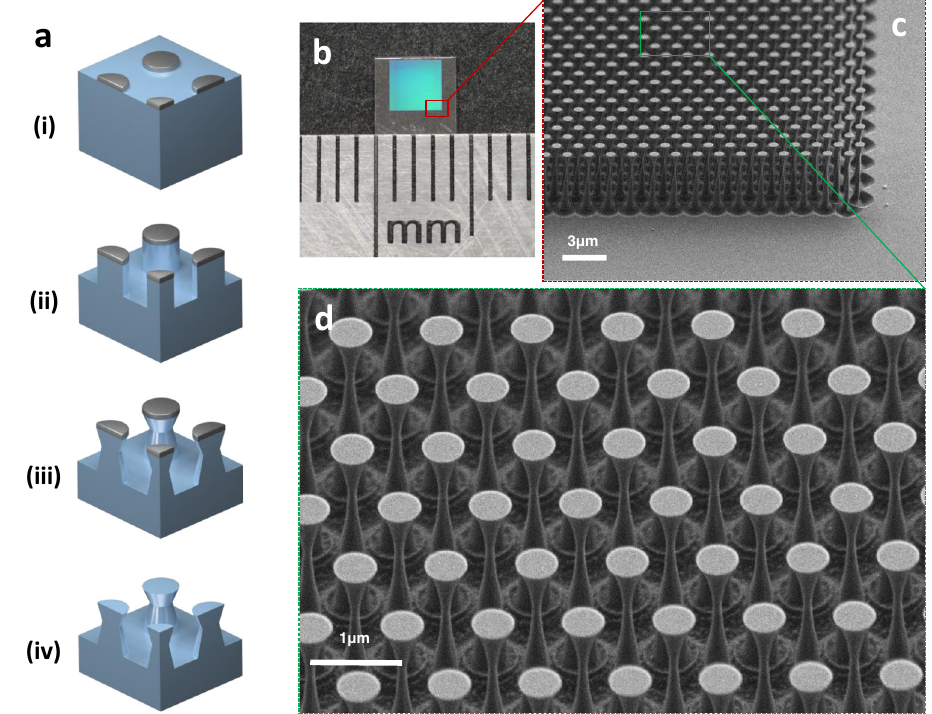
Fig. 2 Diamond surface fabrication and images. a Schematic of the reactive ion beam angled etching (RIBAE) fabrication process. (i) Etch mask is patterned onto the diamond sample surface. (ii) Top-down etch with the sample mounted perpendicular to the ion beam path on a rotating sample stage. (iii) Sample is tilted during etching to obtain the target angle α with respect to the direction of the ion beam, uniformly etching underneath the etch mask. (iv) Mask removal yields an array of 3-D nanostructures etched into the surface of diamond. b Optical image of the diamond mirror on a 4.2 mm × 4.2 mm diamond crystal. Each division on the ruler is 1 mm. Photo Credit: H. A. Atikian, Harvard. c SEM image of the diamond mirror taken at 60° from normal. d Zoomed SEM image of the mirror taken at 40° from normal.